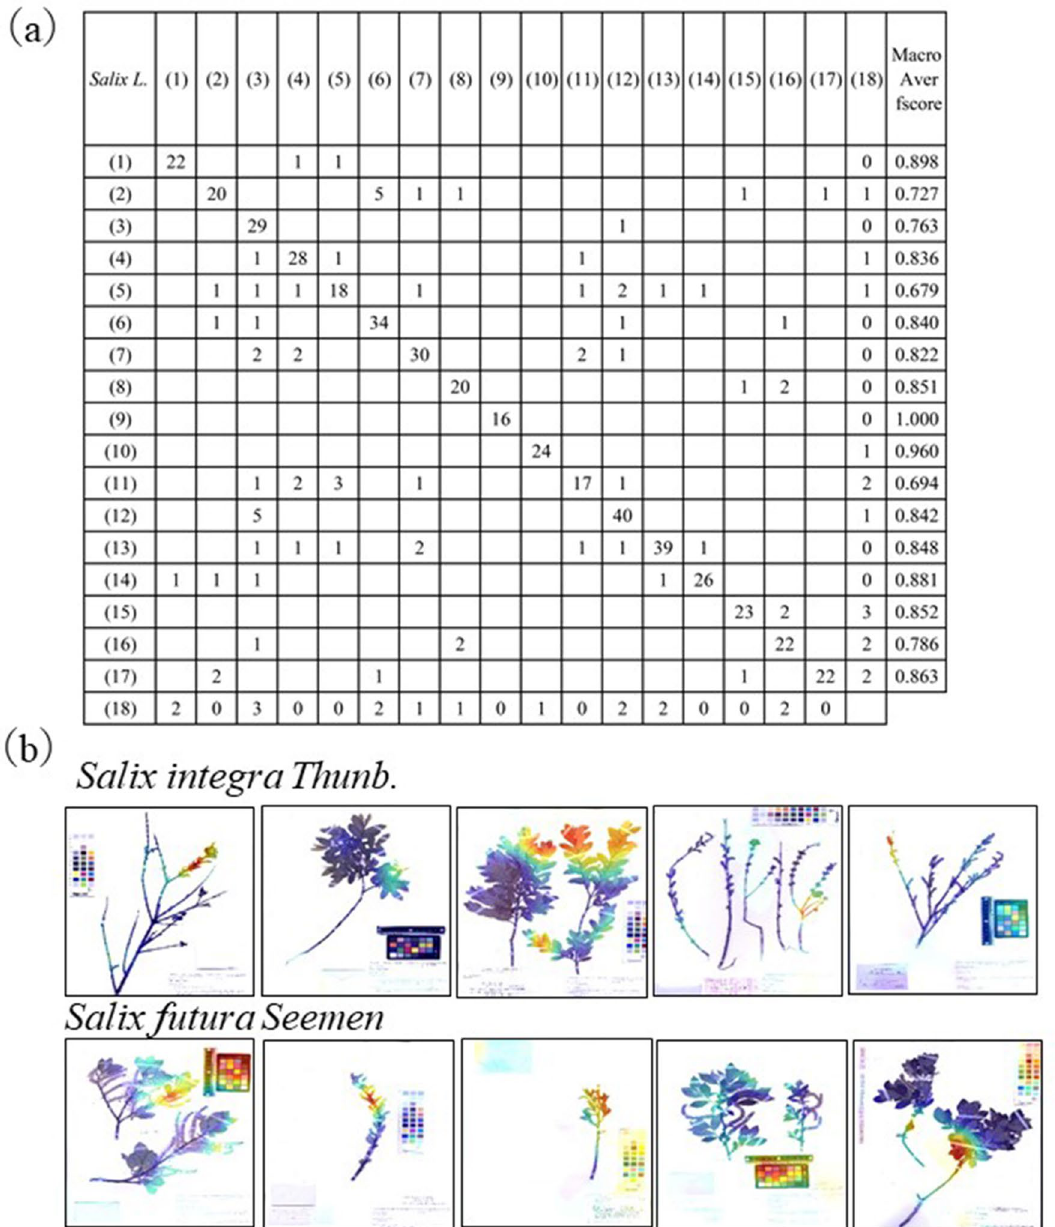
Figure 3. ( a ) A cross-tabulation table was created for the recall and precision values of 17 taxa of Salix L in the third experiment. (1) S. integra Thunb., (2) S. futura Seemen, (3) S. pierotii Miq., (4) S. udensis Trautv. et C.A.Mey., (5) S. miyabeana Seemen subsp. gymnolepis (H.Lév. et Vaniot) H.Ohashi et Yonek., (6) S. vulpina Andersson subsp. vulpina , (7) S. dolichostyla Seemen subsp. serissifolia (Kimura) H.Ohashi et H.Nakai, (8) S. vulpina Andersson subsp. alopochroa (Kimura) H.Ohashi et Yonek., (9) S. eriocataphylla Kimura, (10) S. japonica Thunb., (11) S. dolichostyla Seemen subsp. dolichostyla , (12) S. eriocarpa Franch. et Sav., (13) S. triandra L. subsp. nipponica (Franch. et Sav.) A.K.Skvortsov, (14) S. gracilistyla Miq., (15) S. caprea L., (16) S. chaenomeloides Kimura, (17) S. sieboldiana Blume var. sieboldiana , (18) others. ( b ) Results of Grad-CAM analysis of Salix integra and Salix futura . Red indicates the more important parts while blue represents less important